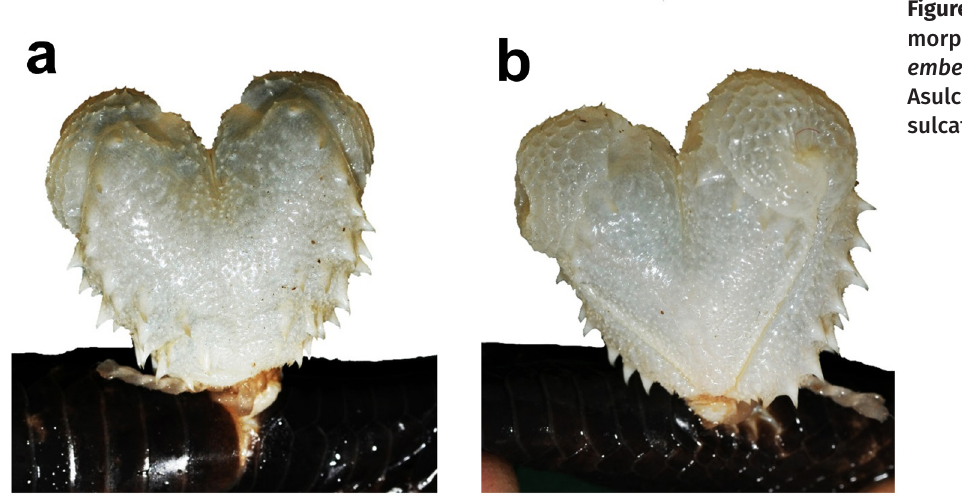
Figure 4. Hemipenial morphology of Oxyrhopus emberti sp. n (MNKR 1223). Asulcate side (Left) and sulcate side